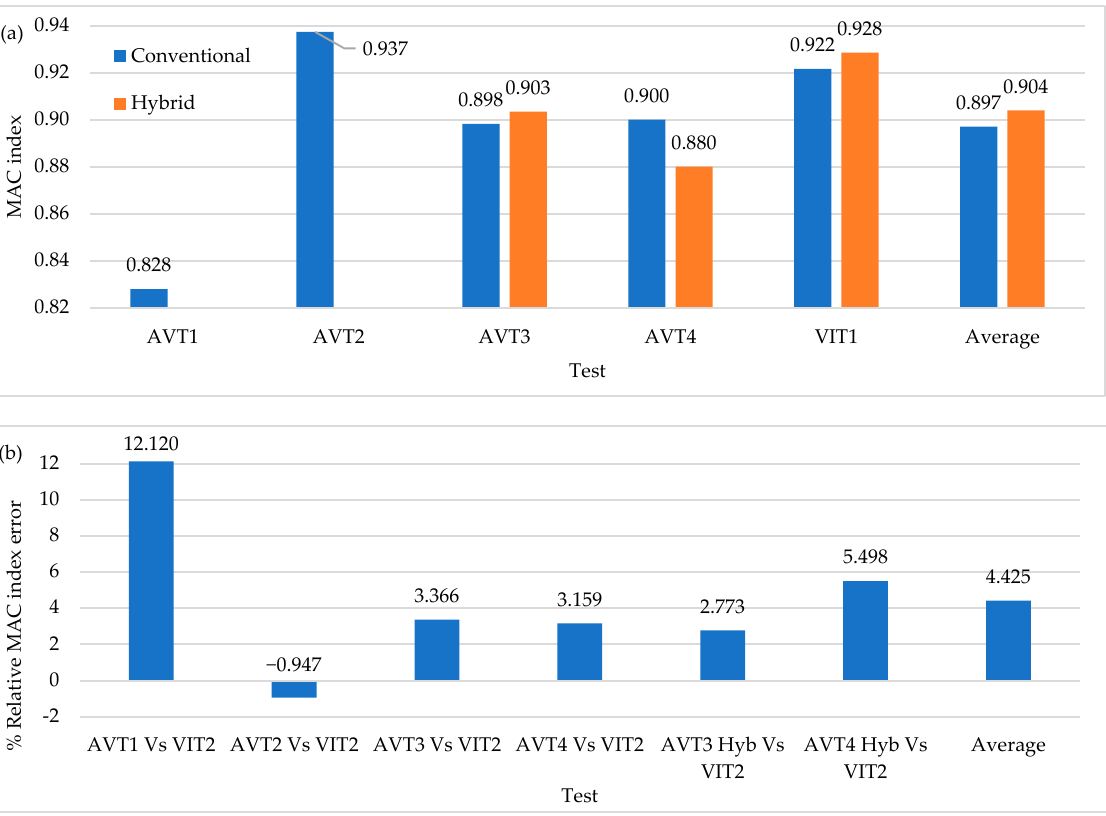
Figure 21. ( a ) Average values of MAC index ( b ) Percentage of relative MAC index error of OSP locations.